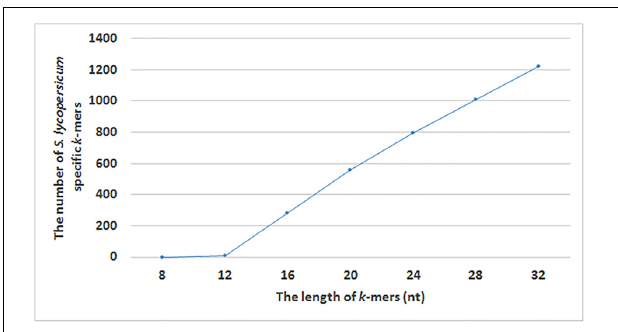
FIGURE 4 | The number of identified S. lycopersicum specific k -mers with different lengths (8, 12, 16, 20, 24, 28, and 32 nucleotides).